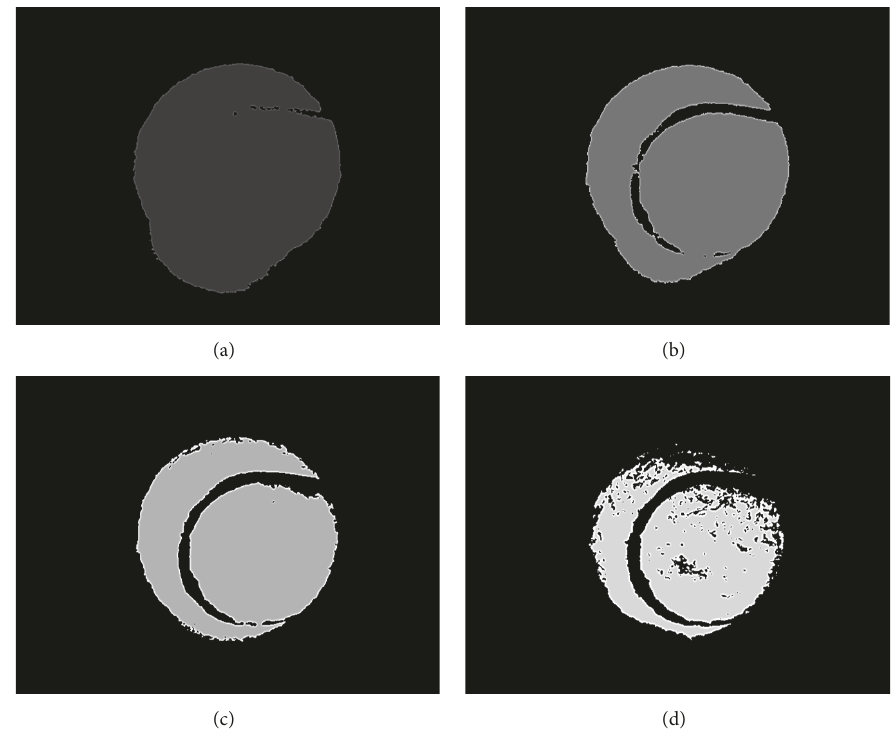
Figure 7: Target effect image with the different minimum threshold value in S component, (a) effect image with the minimum threshold value 50, (b) effect image with the minimum threshold value 100, (c) effect image with the minimum threshold value 150, and (d) effect image with the minimum threshold value 200.